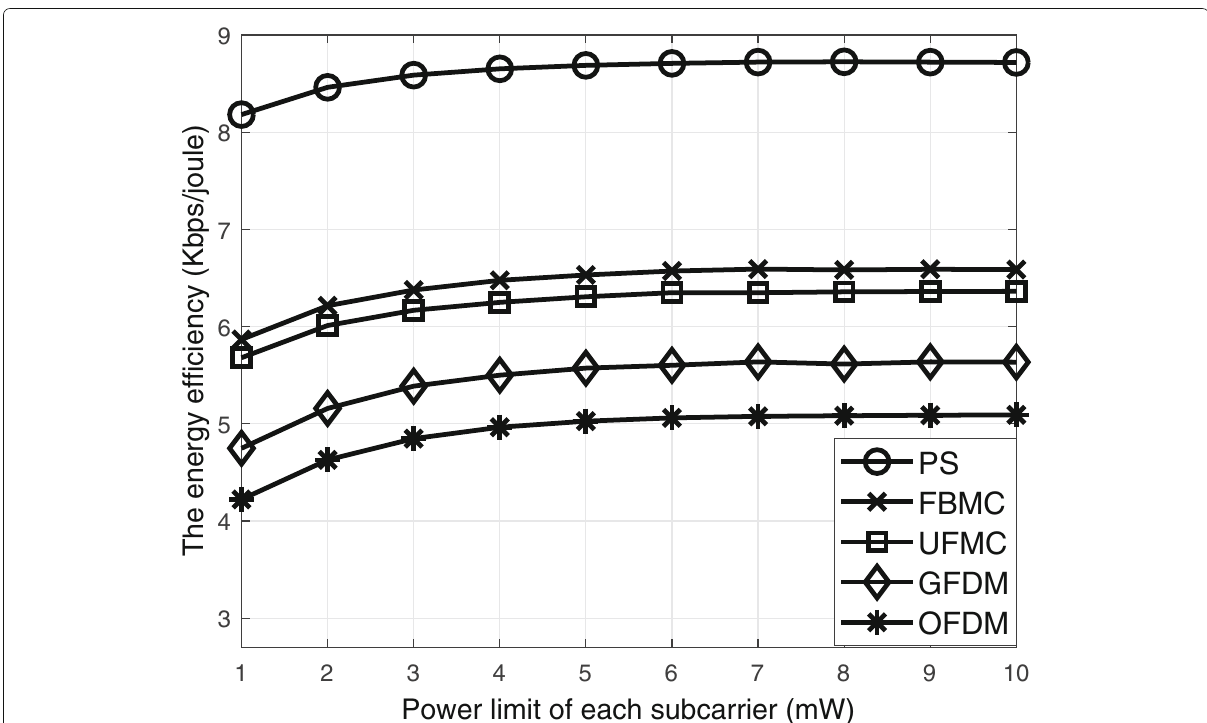
Fig. 7 Energy efficiency versus power limits. The performance of the proposed algorithm using various modulation schemes versus different power limits on subcarriers